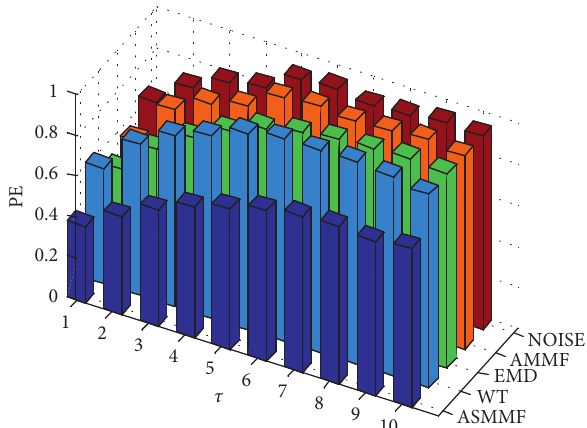
Figure 16: The MPE of denoising results for the chaotic vibration